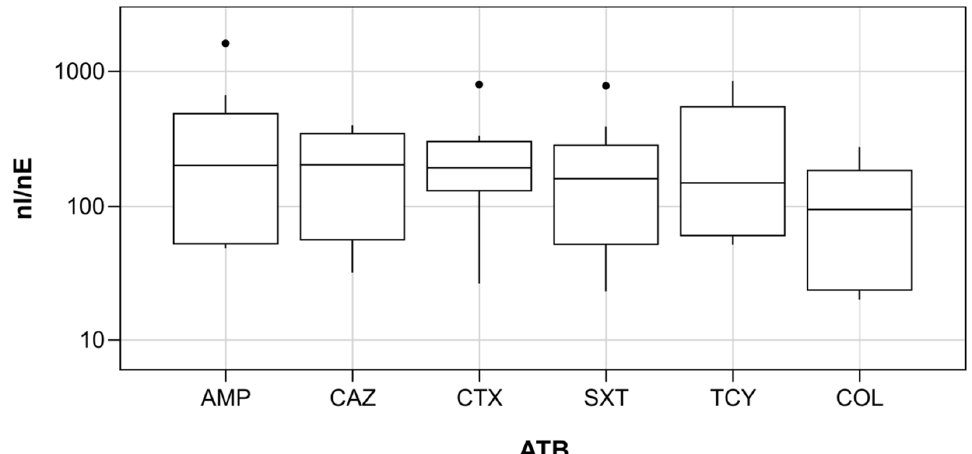
Figure 6. Influent/effluent ratios (nI/nE) of the abundance of culturable Escherichia coli resistant to ampicillin (AMP), ceftazidime (CAZ), cefotaxime (CTX), sulfamethoxazole (SXT), tetracy- cline (TCY) and colistin (COL) measured in the wastewater. ● indicate data points located outside whiskers of the Tukey's boxplot (outliers).